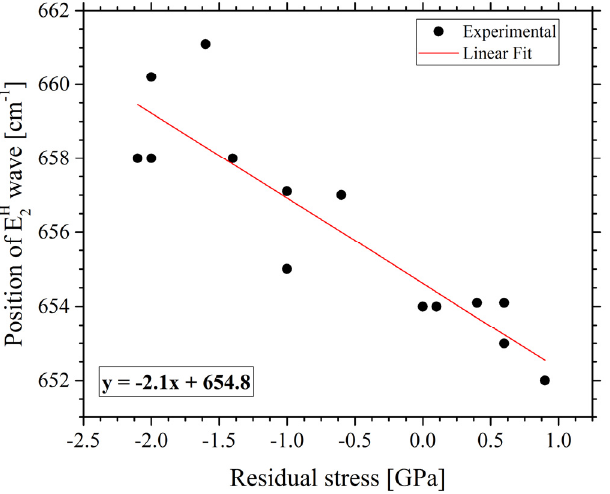
Figure 1. Position of the Raman band relative to the AlN (0002) orientation as a function of the residual stress calculated by the method of radius of curvature on different substrates.